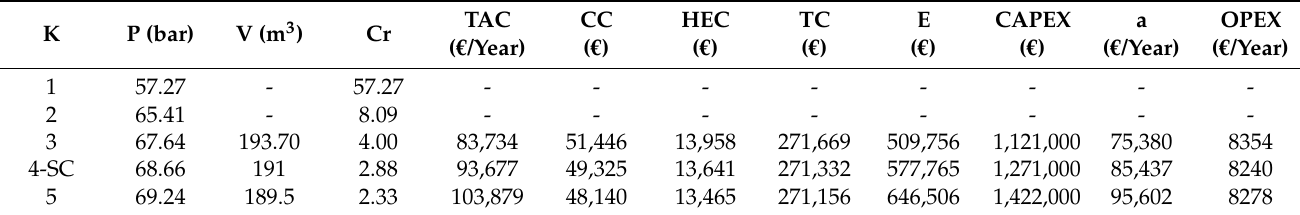
Table 9. Optimization results for the different scenarios, H